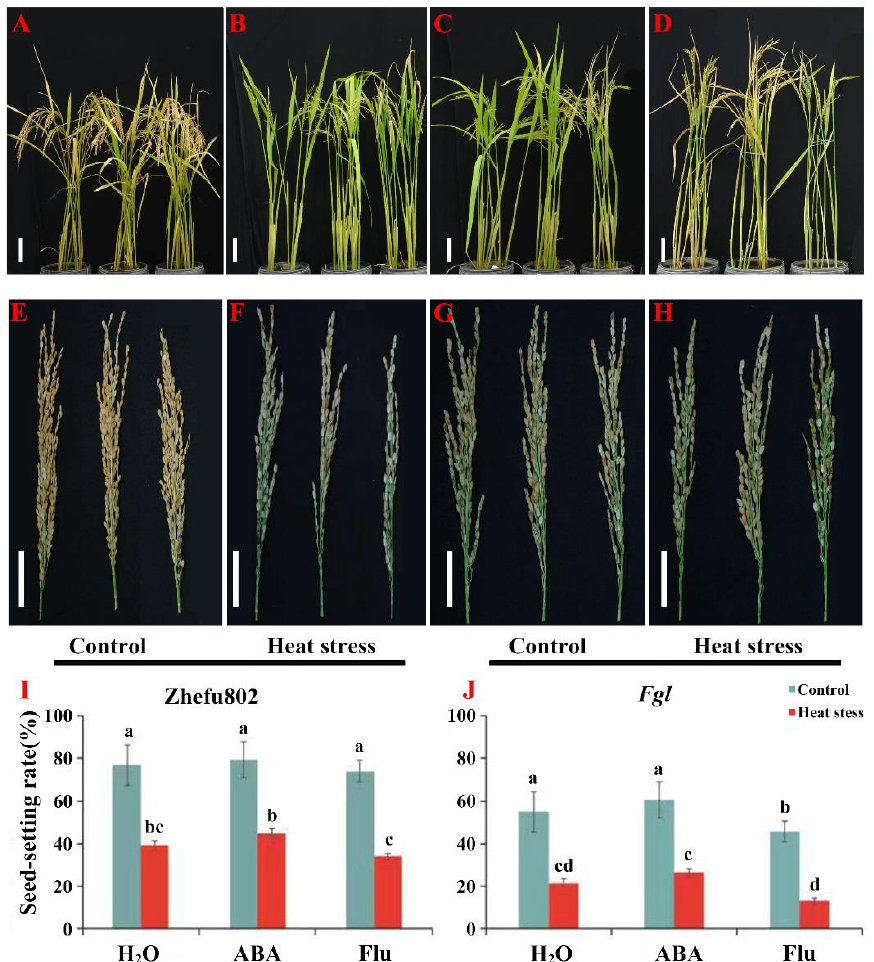
Figure 1. The effects of exogenous ABA on the seed-setting rate of rice under heat stress. ( A , B , E , F ) are Zhefu802 plants. ( C , D , G , H ) are Fgl plants. ( I , J ) are the rice seed-setting rate for Zhefu802 and Fgl respectively. ABA, abscisic acid. Flu, the ABA synthase inhibitor fluridone. In ( A – H ), three pots or three panicles were selected from H 2 O, ABA, and Flu treatment in sequence. The reference scale from ( A – D ) and ( E – H ) represents 10 and 5 cm respectively. Error bars denote standard deviations ( n = 3). Different letters indicate significant differences between the control and heat stress treatments within a genotype by two-way analysis of variance (temperature and treatment) ( p < 0.05).